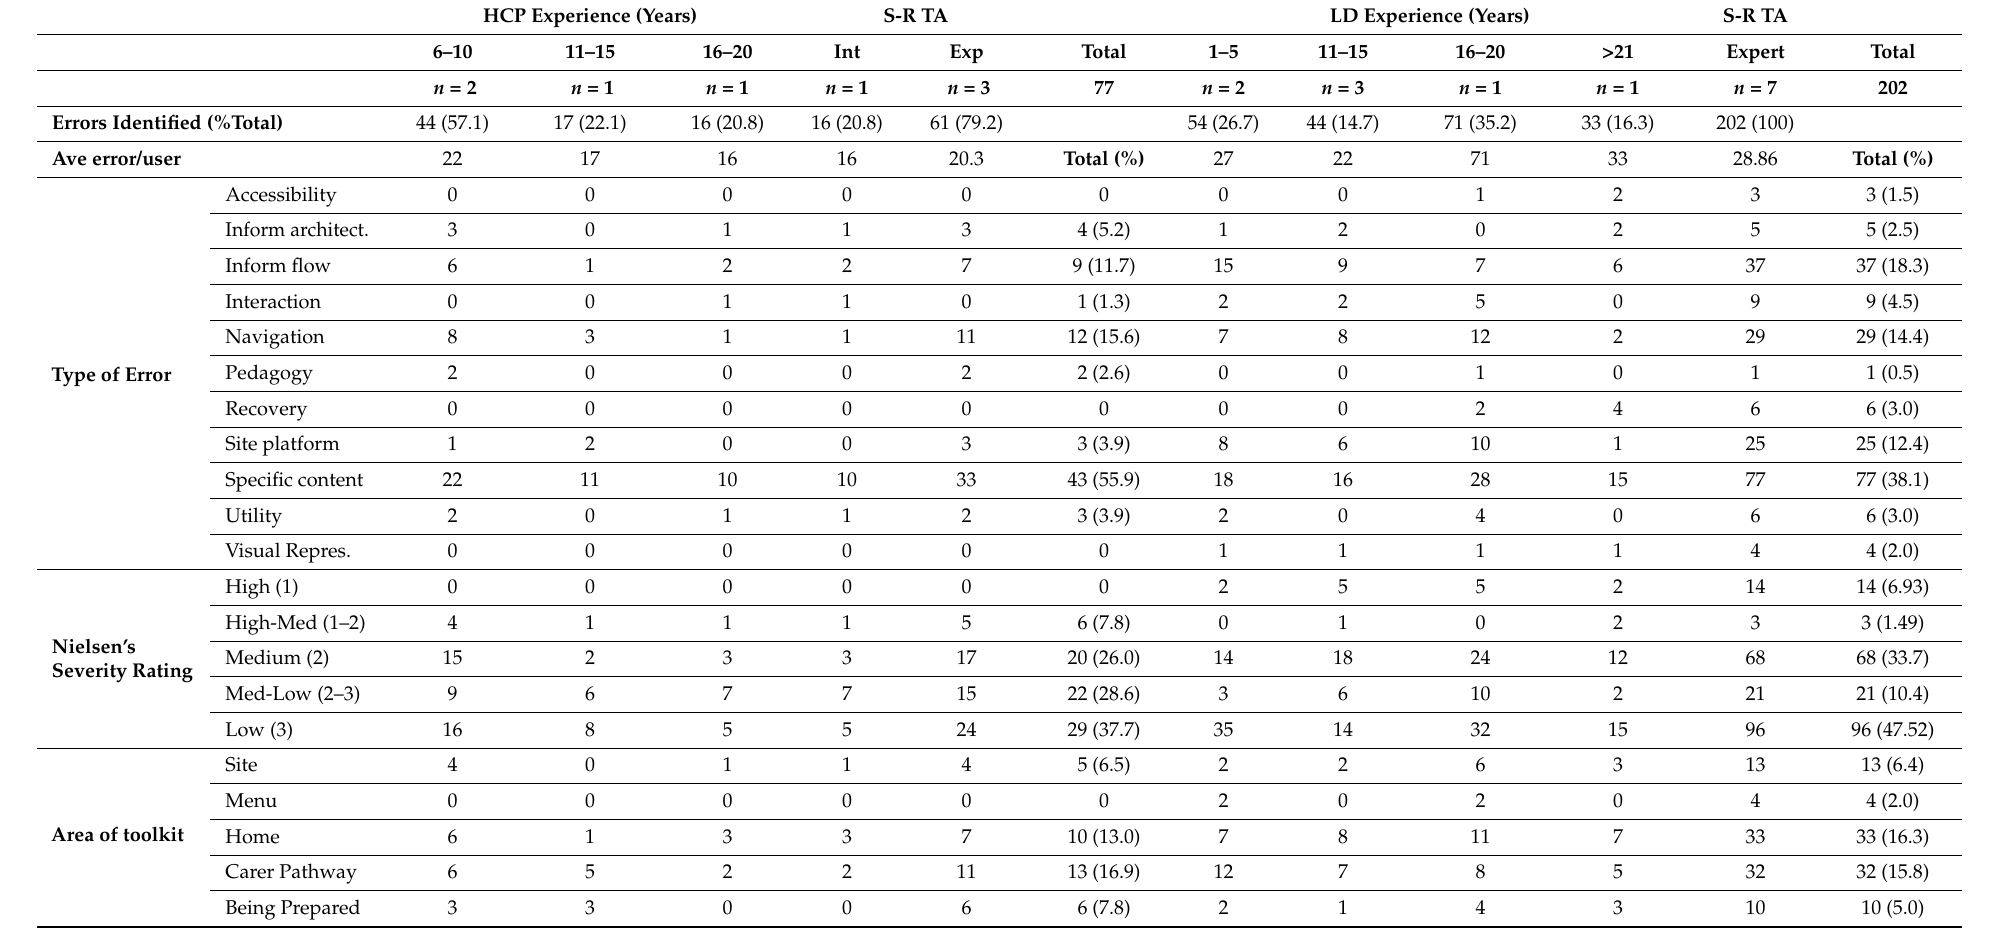
Table A1. Error frequencies identified by Healthcare Professionals and Learning Designers within the